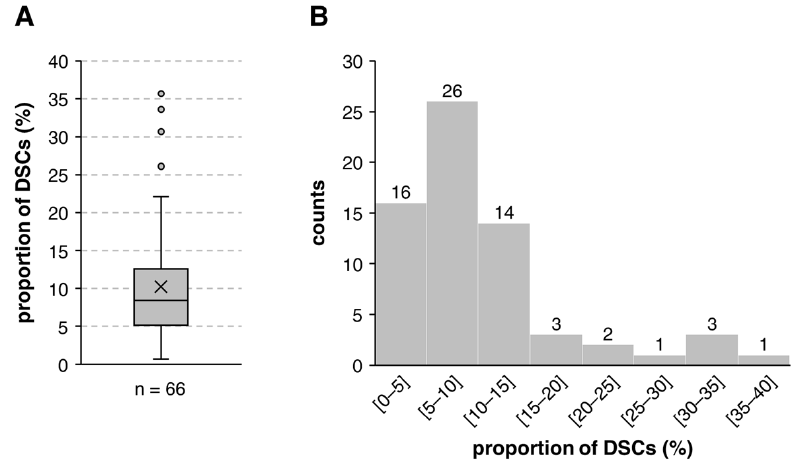
Figure 1. Frequency of stem cells in DSC ‐ fibroblast co ‐ cultures. Dermal cells were cultured in stem cell medium for up to two weeks to form spheres. The spheres were enzymatically dissociated with Accutase™, and the percentage of DSCs (NGFRp75 ‐ positive cells) in the culture was determined via flow cytometry. ( A ) Boxplot displaying the median with 25th/75th percentiles. The cross ( × ) inside the box indicates the mean DSC frequency. Dots represent outliers. ( B ) The histogram shows the abundance distribution of DSC frequencies of individual donor cell strains divided into ranges of 5%. Results from 66 donors.